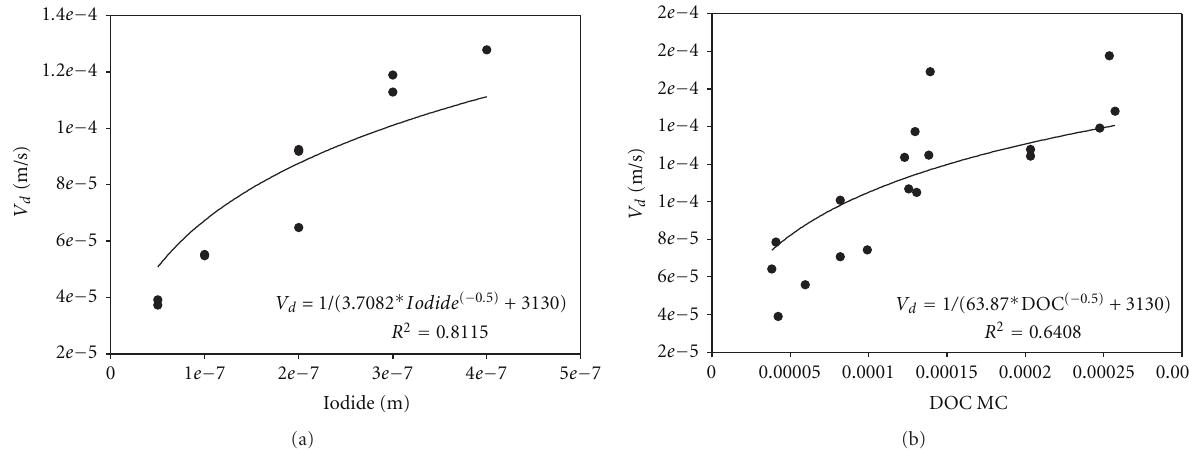
Figure 2: Experimental data from Martino et al., (2012), where deposition velocity of ozone was measured as a function of varying (a) iodide and (b) DOC concentrations.